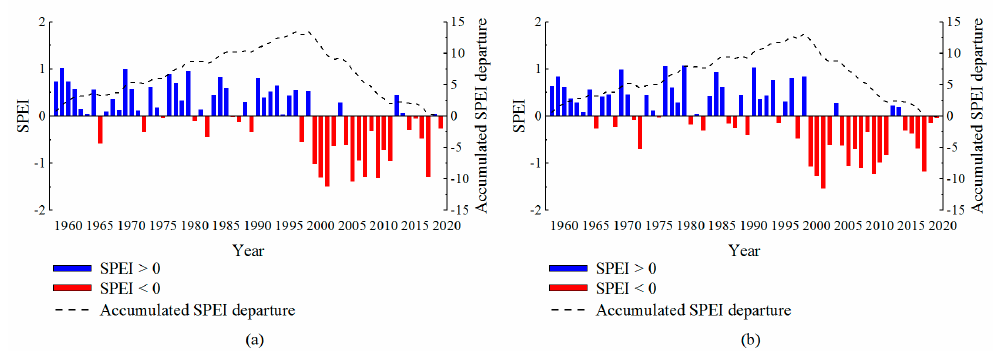
Figure 2. The ( a ) changes of annual standardised precipitation evapotranspiration index (SPEI) values and ( b ) plant growth period SPEI values, over the years.